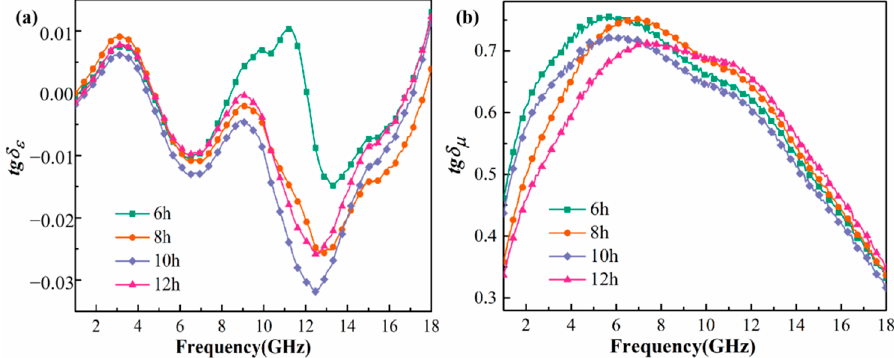
Figure 7. Frequency dependences of tg δ ε ( a ) and tg δ μ ( b ) of Fe 73.2 Si 16.2 B 6.6 Nb 3 Cu 1 nanocrystalline alloy powder.